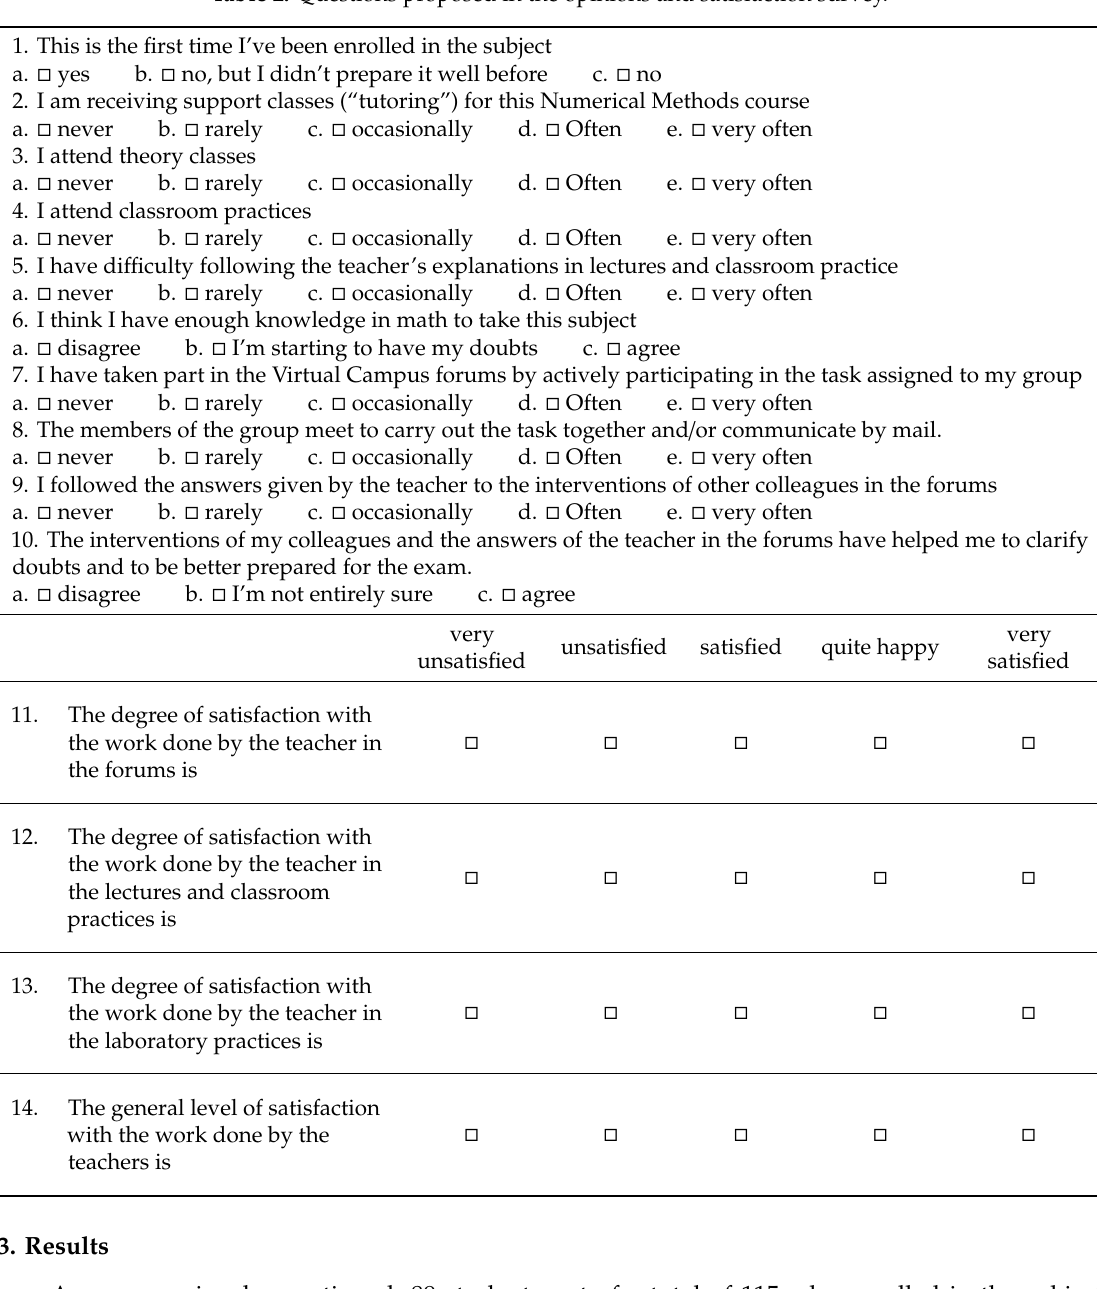
Table 2. Questions proposed in the opinions and satisfaction